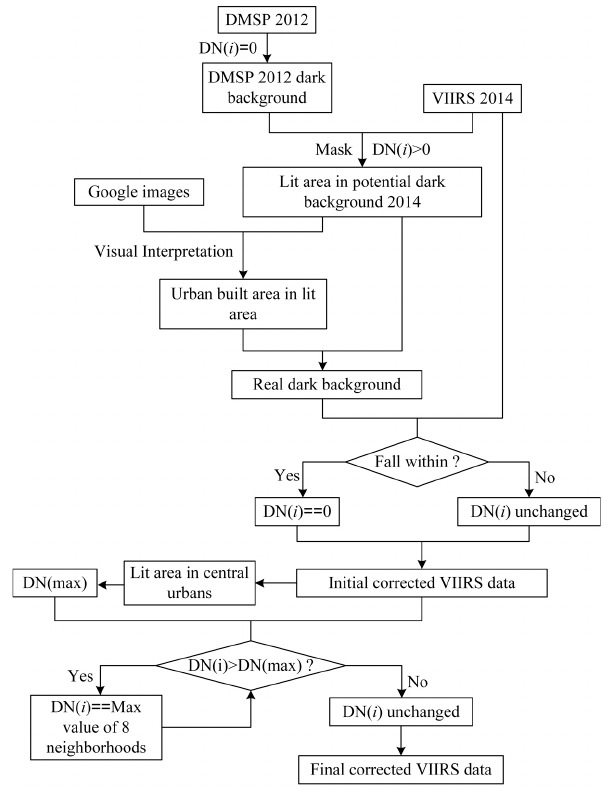
Figure 4. Processing flow chart for lighting correction of VIIRS nighttime light data.